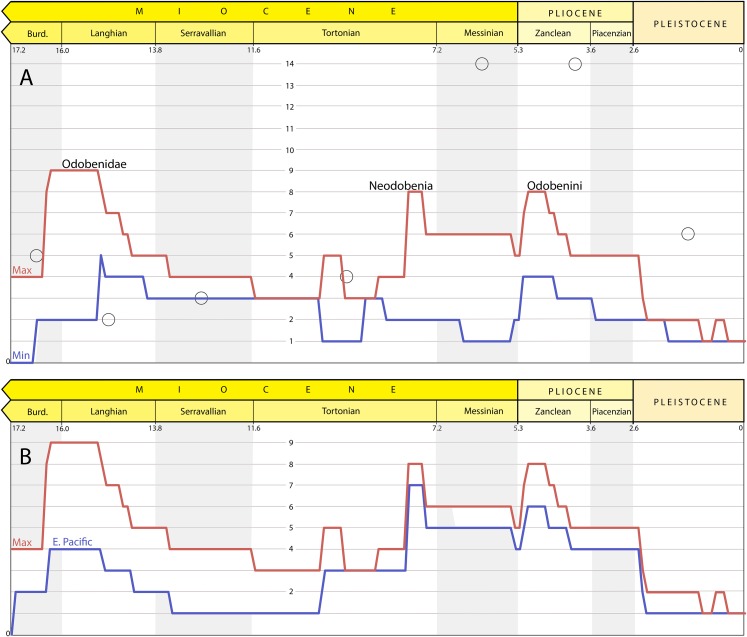
Richness estimates for Odobenidae.(A) Maximum (red) and minimum (blue) lineage counts accounting for ghost lineages and stratigraphic uncertainty. Peaks on the maximum richness curve labelled with corresponding clade originations. Open circles are from stage-binned analysis that includes undescribed specimens (includes both “small- and large-bodied” forms; Boessenecker & Churchill, 2018). (B) Maximum overall (red) and maximum of trees with East Pacific taxa only (blue) lineage counts.